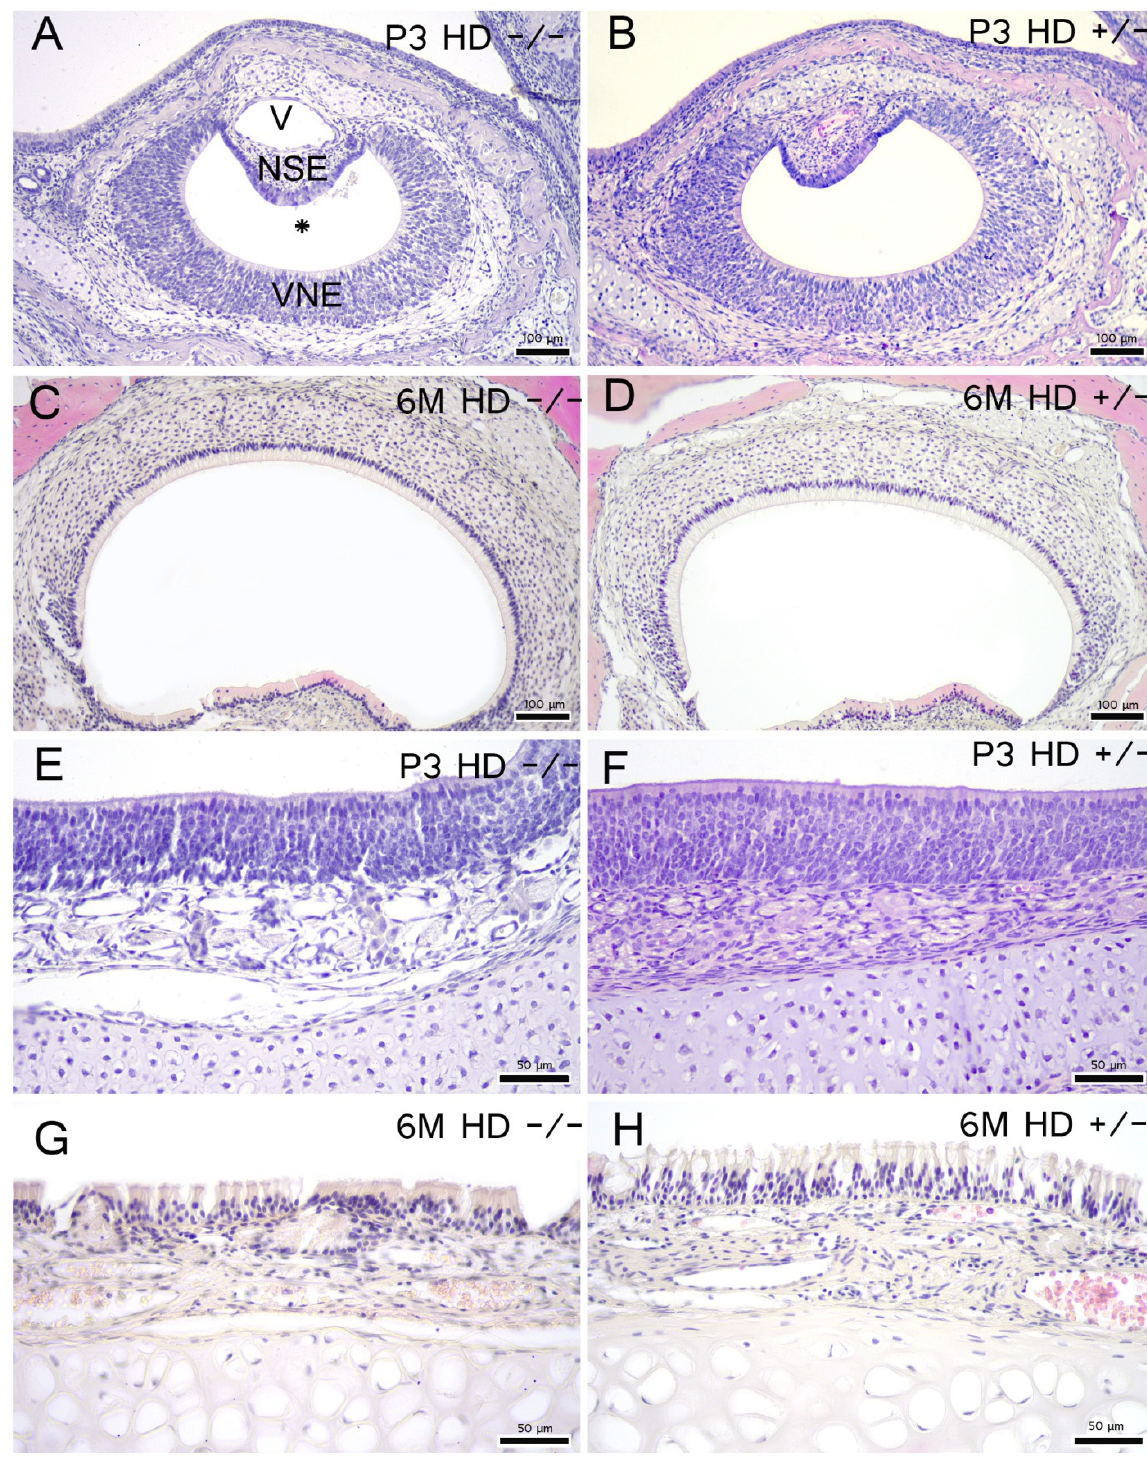
Figure 2. Overview of vomeronasal and main olfactory epithelia morphology: H&E staining of 3-day-old (P3) and 6-month-old (6 M) vomeronasal epithelium ( A – D ) and main olfactory epithelium ( E – H ). The semilunar-shaped VNO consists of a vomeronasal duct (*), sensory vomeronasal epithelium (VNE), non-sensory epithelium (NSE), vomeronasal cartilage (Ca), vomeronasal nerve and glands (not indicated). V = vein. After Witt and Wo ź niak [29]. Scale bars: ( A – D ) 100 µm; ( E – H ) 50 µm. To investigate cell proliferation and apoptosis, 5-bromo-2 ′ -deoxy-uridine (BrdU) and activated caspase-3 reactions were performed [30–32]. Two hours before euthanasia,